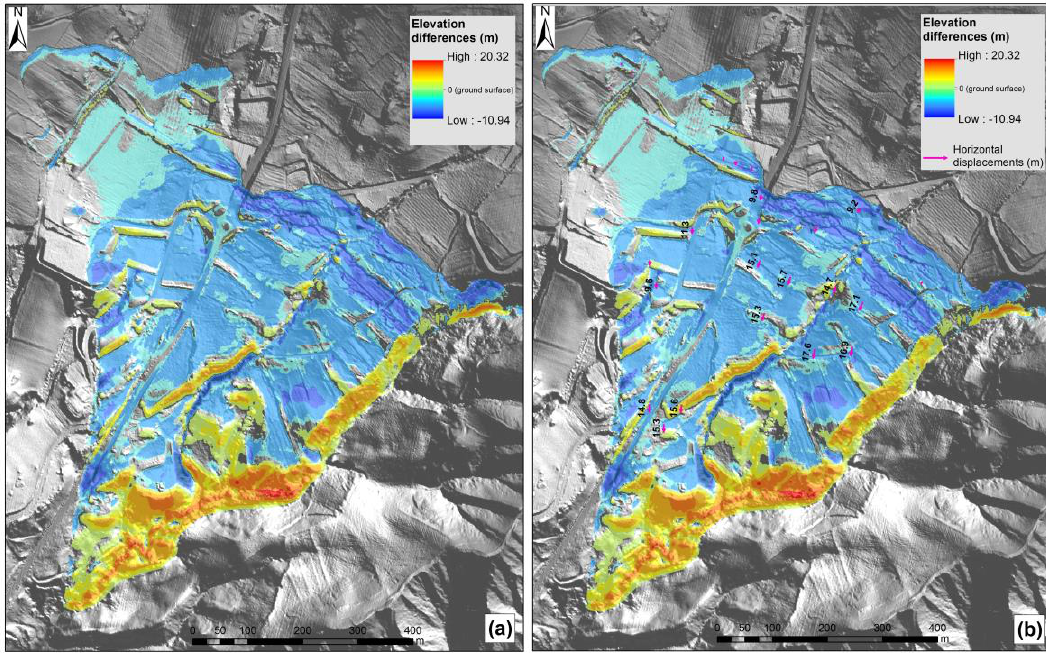
Figure 6. Spatial distribution of the elevation differences, derived by subtracting jul2013DTM from dec2013DTM ( a ), and overlapping of the spatially distributed elevation differences and horizontal displacement vectors ( b ).